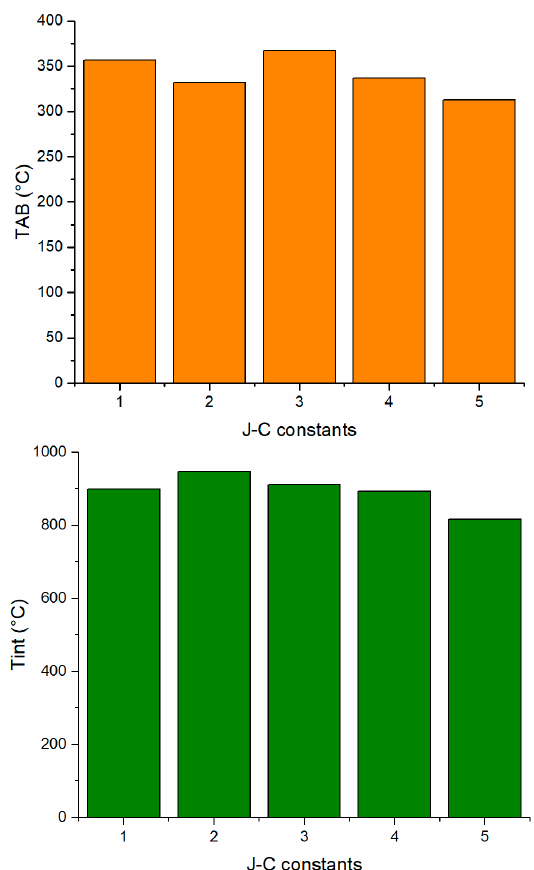
Figure 5. Sensitivity study of input J-C constants. T AB ( top ) and T int ( bottom ) denote the average temperatures at primary shear zone (PSZ) and the average temperatures at secondary shear zone (SSZ) respectively. Set 1 to Set 4 represent prediction with different sets of J-C constants. Set 5 represents documented temperatures.